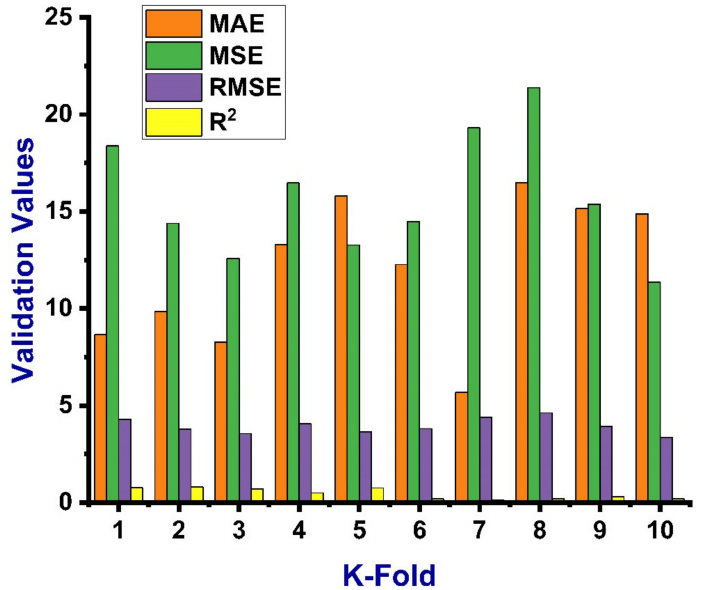
Figure 9. Statistical Indication for k-fold cross validation for the ANN